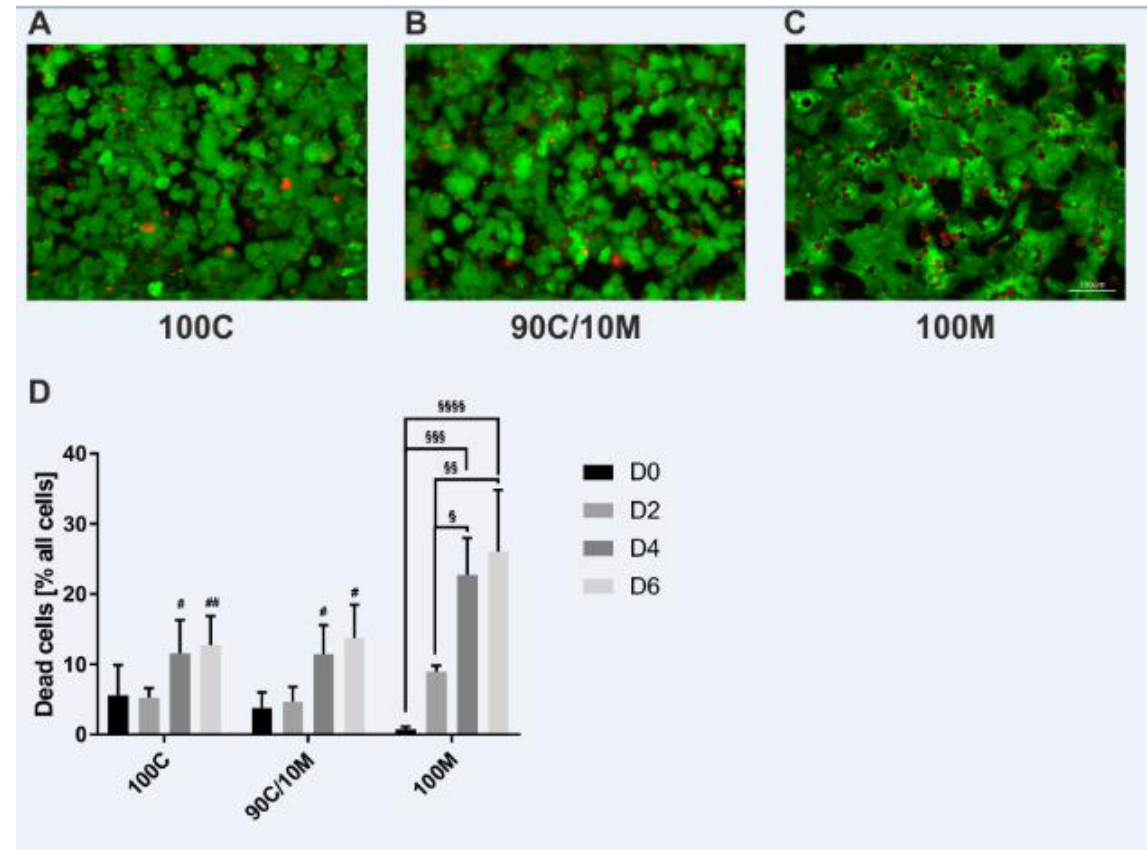
Figure 4: Cell viability of primary human hepatocytes (PHHs) in sandwich cultures (SCs) between dif- ferent extracellular matrices (ECMs). PHHs from 3 donors were cultured for up to 6 days between two layers of ( A ) pure collagen type I (100C), ( B ) collagen type I supplemented with 10 % Matrigel (90C/10M) or ( C ) pure Matrigel (100M). Viable cells were detected by the intracellularly converted fluo- rescent calcein (green). Nuclei of dead cells appear red after binding of the fluorescent ethidium ho- modimer-1. (A-C) Representative fluorescence microscopy images of PHH SCs after 6 days of cultiva- tion are shown. Magnification: 200x. Scale Bar 100 µm. ( D ) Cell counts were assessed manually in 3 randomly chosen microscopy images per ECM type on days 0, 2, 4 and 6 of cultivation. Data are shown as mean + SEM, n = 3, two-way ANOVA and Bonferroni correction for multiple testing, statistical signif- icance was assumed at * p ≤ 0.0332, ** p ≤ 0.0021, *** p ≤ 0.0002, **** p < 0.0001. Significant differences between PHHs cultured on one of the various matrices in comparison to PHHs cultured on 100M of the same day are marked with #. Significant differences observed at different time points of PHHs cultured on the same ECM are marked with